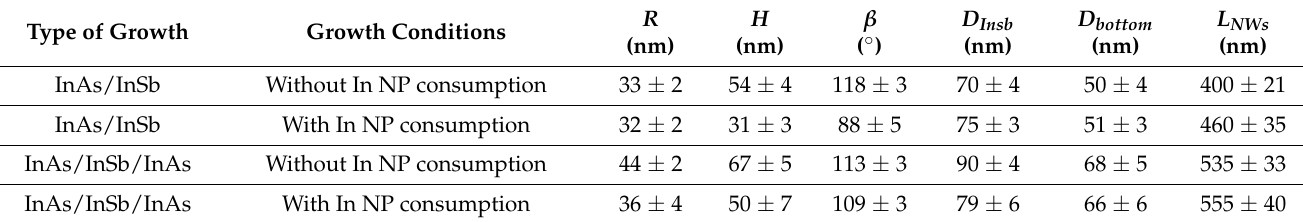
Figure 4. ( a ) SEM images of InAs/InSb heterostructured NW (left) and InSb/InAs QD NWs (right), obtained with partial consumption of In NP under F As = 1 Torr for 1 min. ( b ) SEM images of InAs/InSb heterostructured NW (left) and InSb/InAs QD NWs (right) obtained without consumption of the In NP. In both cases the growth of the top InAs segment was performed with line pressures of F In = 0.30 Torr F As = 0.30 Torr, and growth time of 15 min at T InAs = 440 °C. Table 1. Measured and calculated geometrical parameters for the samples reported in Figure